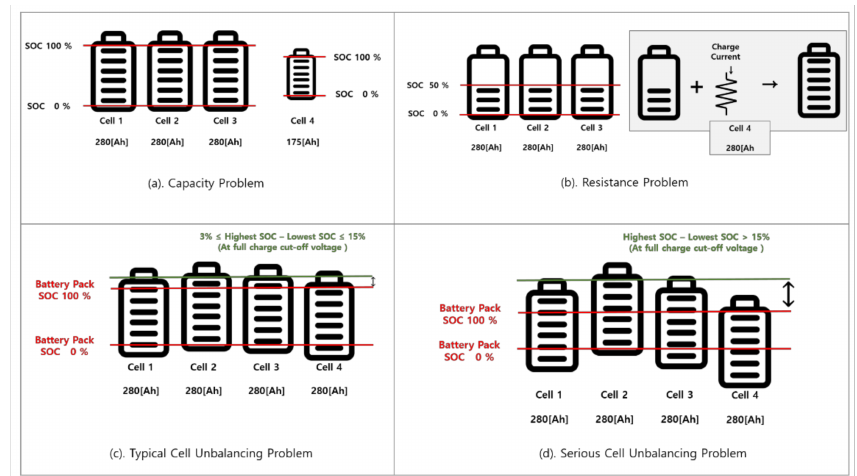
Figure 3. Types of causes of abnormalities (( a ) capacity problem, ( b ) resistance problem, ( c ) typical cell balancing problem, and ( d ) serious cell balancing problem).